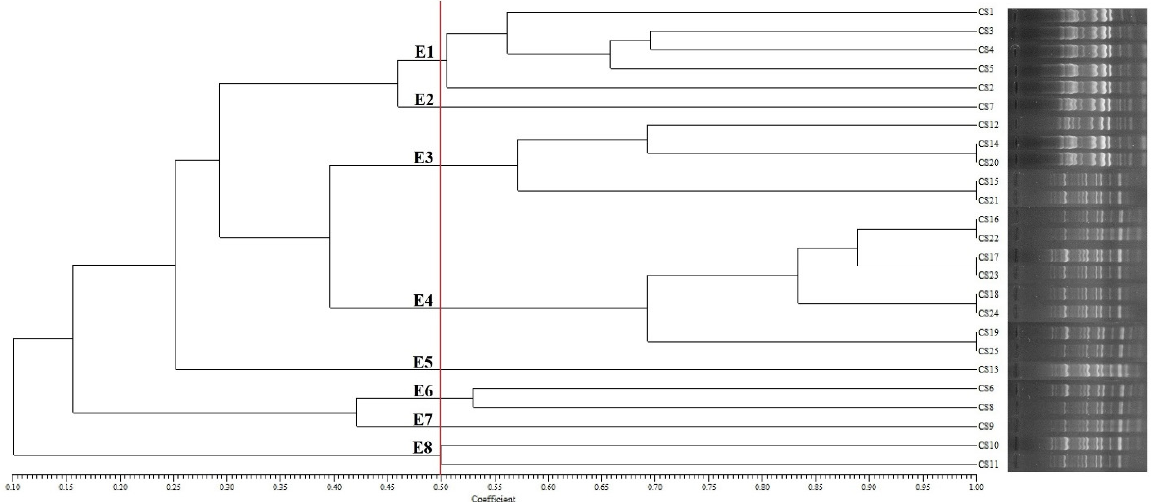
Figure 3. UPGMA dendrogram of C. sakazakii isolates from PIFM samples indicating the Dice coefficient based on ERIC-PCR